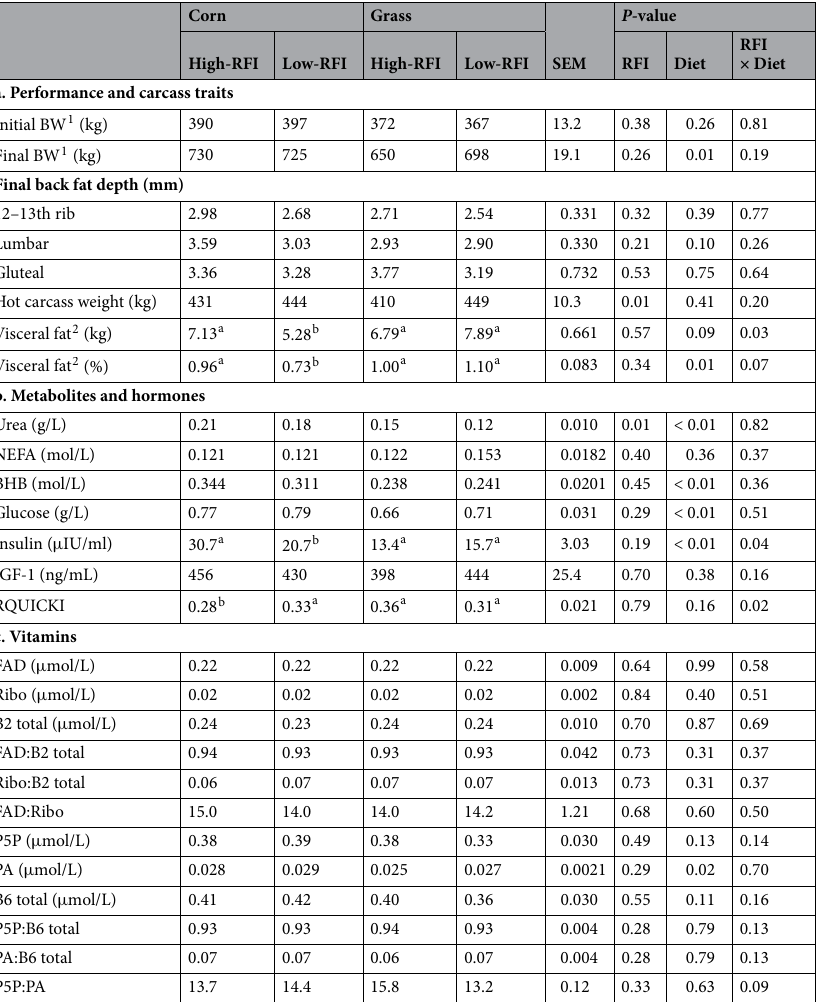
Table 2. Animal performances and plasma biochemical parameters in High versus Low residual feed intake (RFI) young bulls fed corn- or grass-silage diets. a,b: Means are compared only within each diet. Different letters means significant differences according to Tukey test ( P < 0.05). 1: Body weight at the begining and the end of the RFI test. 2: Kindey, pelvic and mesenteric fat. 3: NEFA Non-esterified fatty acid, BHBA β -hydroxybutyrate, IGF-1 Insulin growth factor-1; RQUICKI